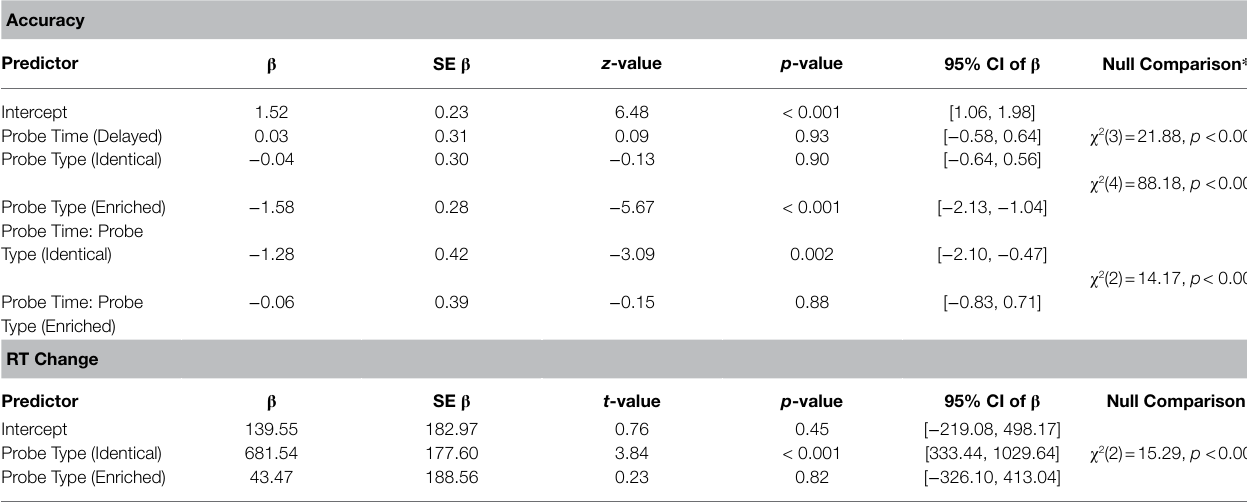
TABLE 1 | Top: logistic regression of recognition accuracy to the three probe types at the immediate and delayed probe time points. Bottom: Linear regression of response time change from immediate to delayed probe presentation. Accuracy